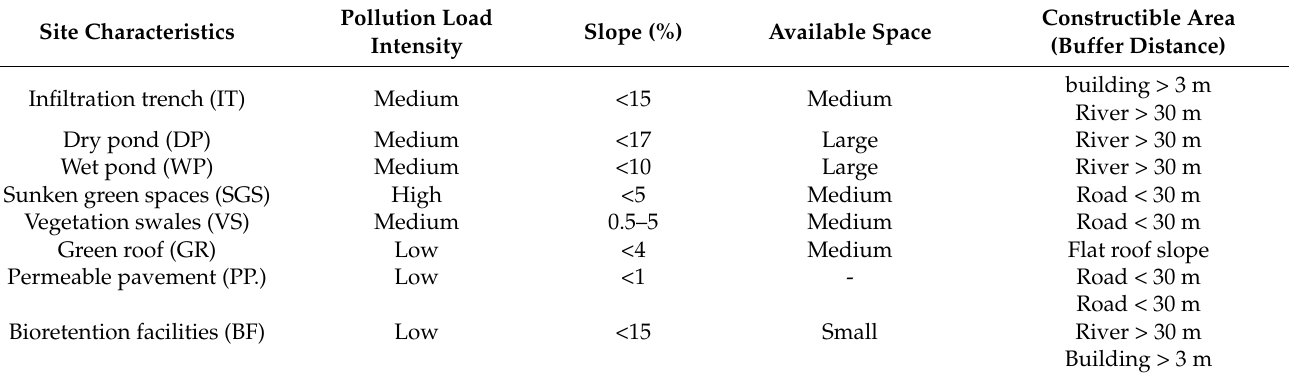
Table 1. Site suitability indices for GI.